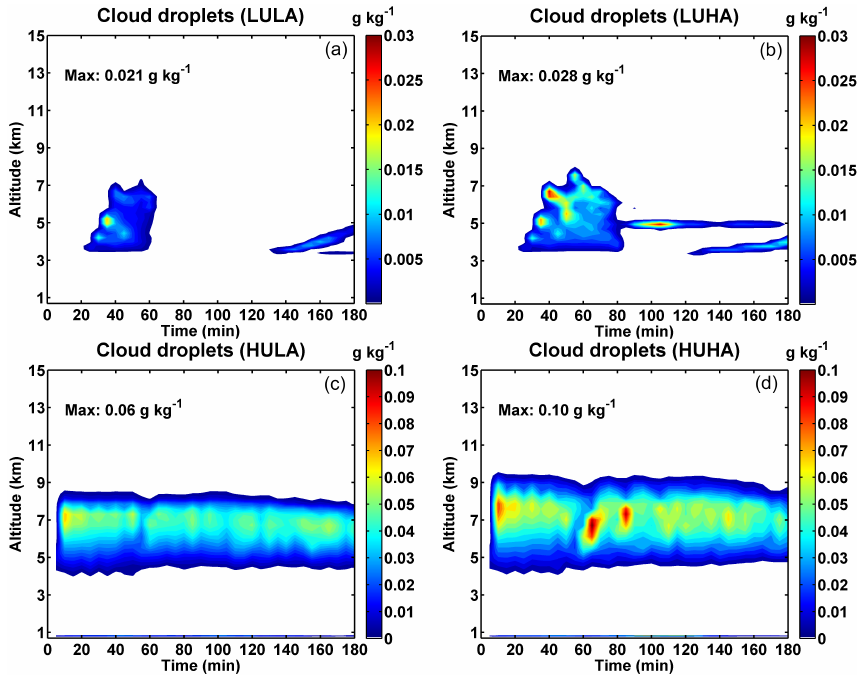
Figure 6. Time evolution of horizontally averaged cloud water content (gkg − 1 ) as a function of altitude for four extreme cases, which are referred to as (1) LULA: low updrafts (2000Wm − 2 ) and low aerosols (200cm − 3 ); (2) LUHA: low updrafts (2000Wm − 2 ) and high aerosols (100000cm − 3 ); (3) HULA: high updrafts (300000Wm − 2 ) and low aerosols (200cm − 3 ); and (4) HUHA: high updrafts (300000Wm − 2 ) and high aerosols (100000cm − 3 ). Maximum values for each episode are also